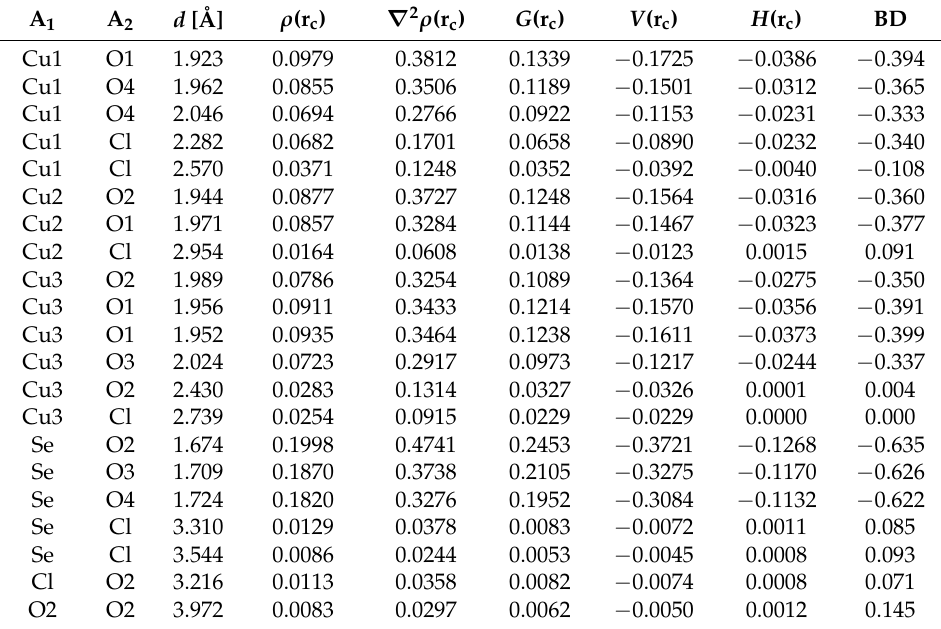
Table 4. Bond critical points in the crystal structure of α -Cu 5 O 2 (SeO 3 ) 2 Cl 2 and their properties.